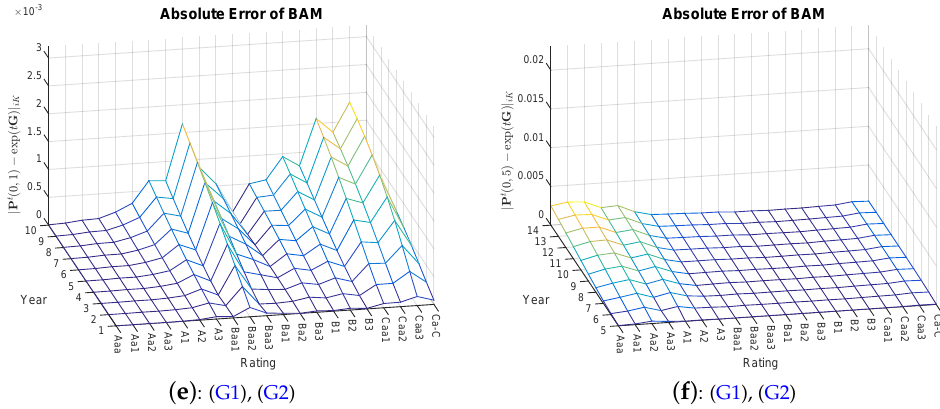
Figure 1. Absolute errors of the methods WA, QOG and BAM (QOG and BAM optimizations based on Constraints (G1) and (G2)) with starting point X DMPG P Moodys XXL ( 0,1 ) ; right side: ( b , d , f ) transition matrix P Moodys XXL ( 0,5 )